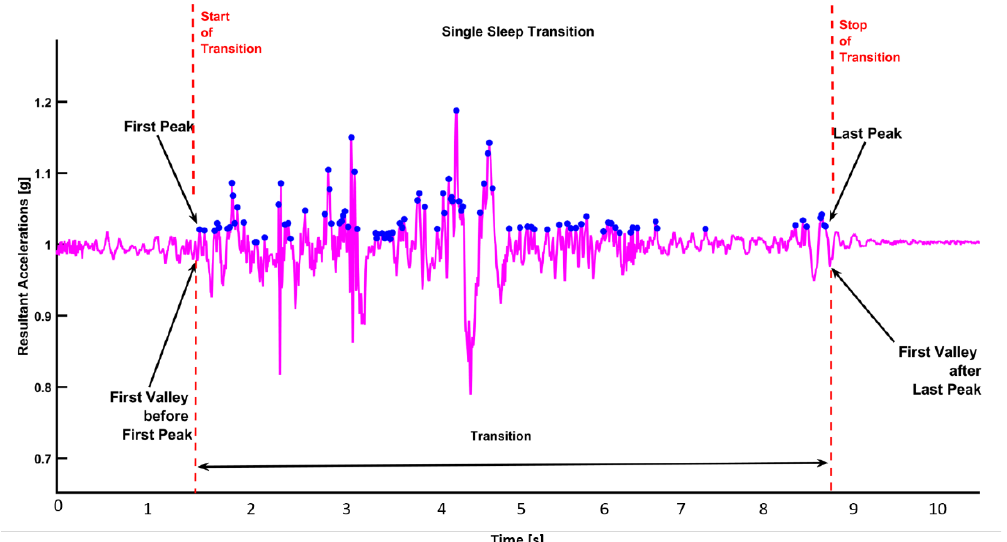
Figure 4. Start and stop events of a transition.